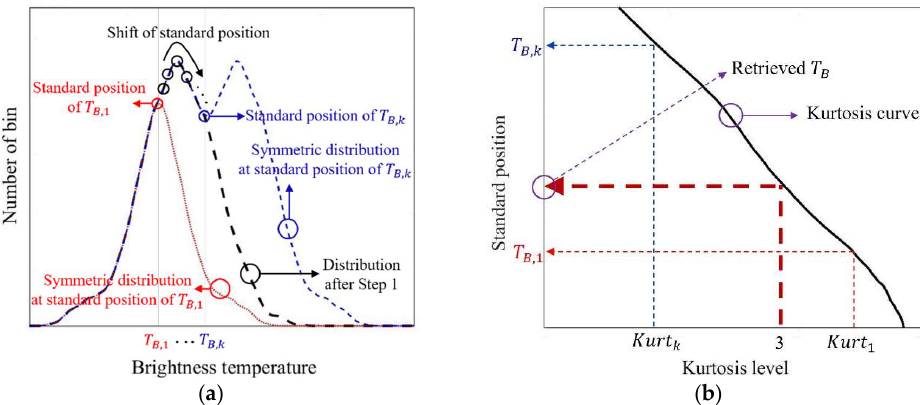
Figure 3. ( a ) Distribution from the remaining bins (black line) in Figure 2, and the examples of two symmetric distributions from the standard position of T B ,1 and T B , k (red and blue lines, respectively); ( b ) standard position of symmetric distribution versus kurtosis level.